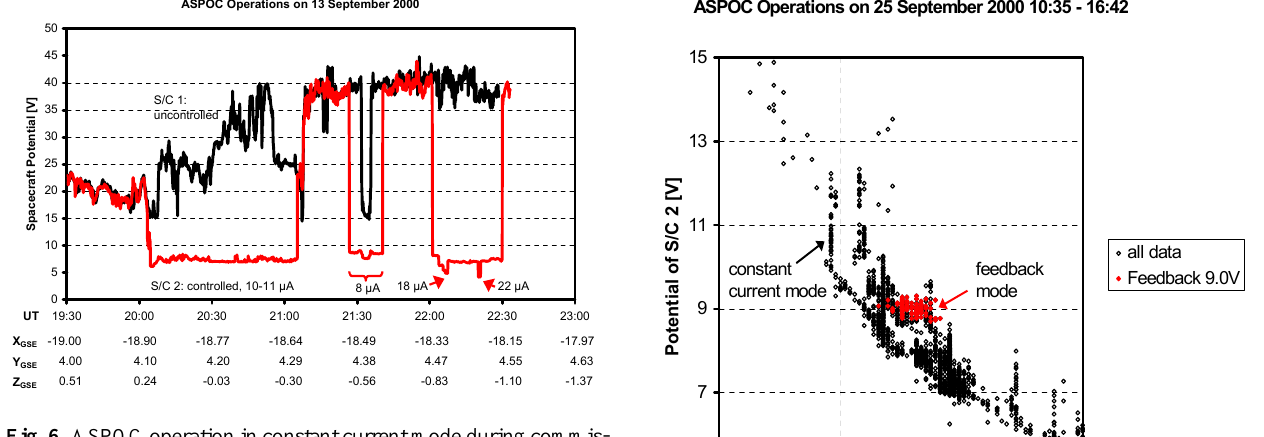
Fig. 6. ASPOC operation in constant current mode during commis- sioning of spacecraft 2 on 13 September 2000. Positions of space- craft 2 are given in Earth radii.